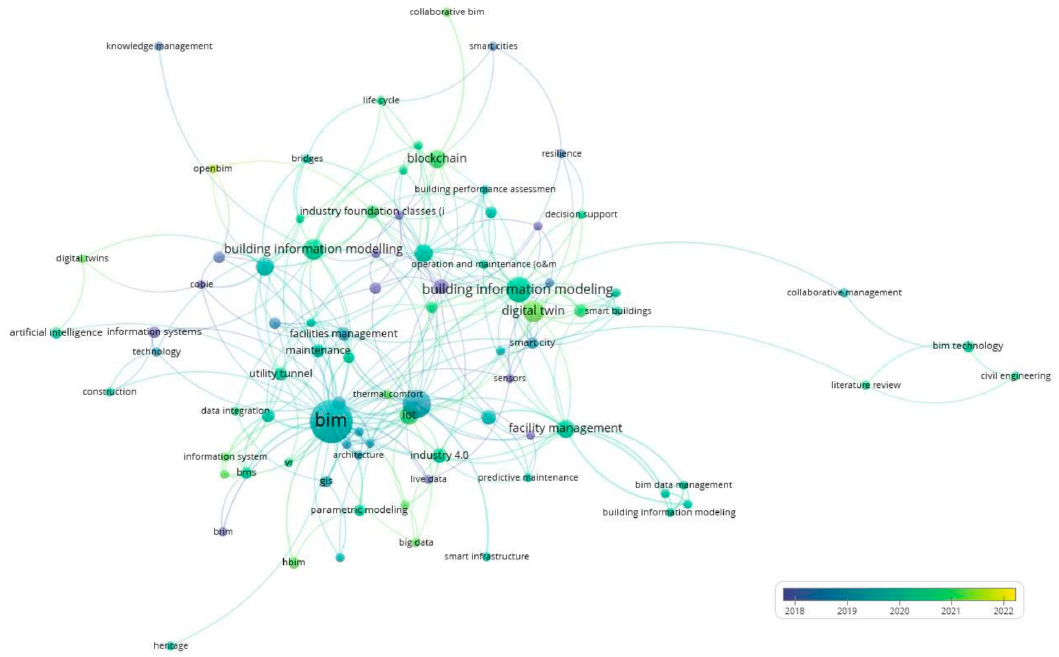
Figure 4. Keywords referenced by year. Made with VOSviewer.